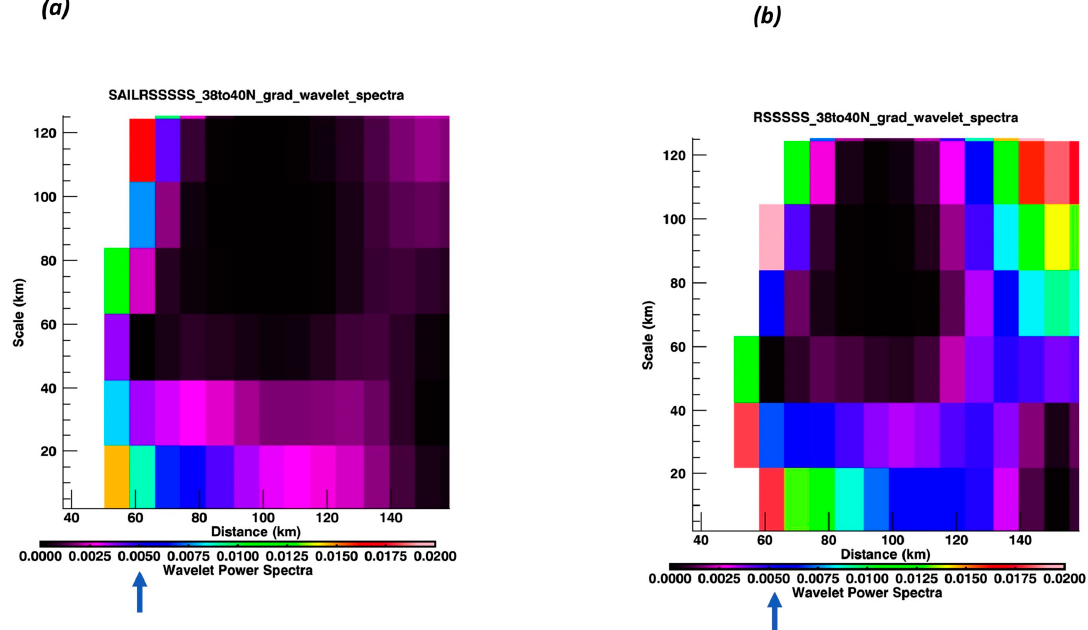
Figure 12. ( a , b ). Wavelet spectra from 38°N to 40°N for ( a ) SAILSSS and ( b ) RSSSSS. Arrows indicate the color associated with the 95% level of confidence.